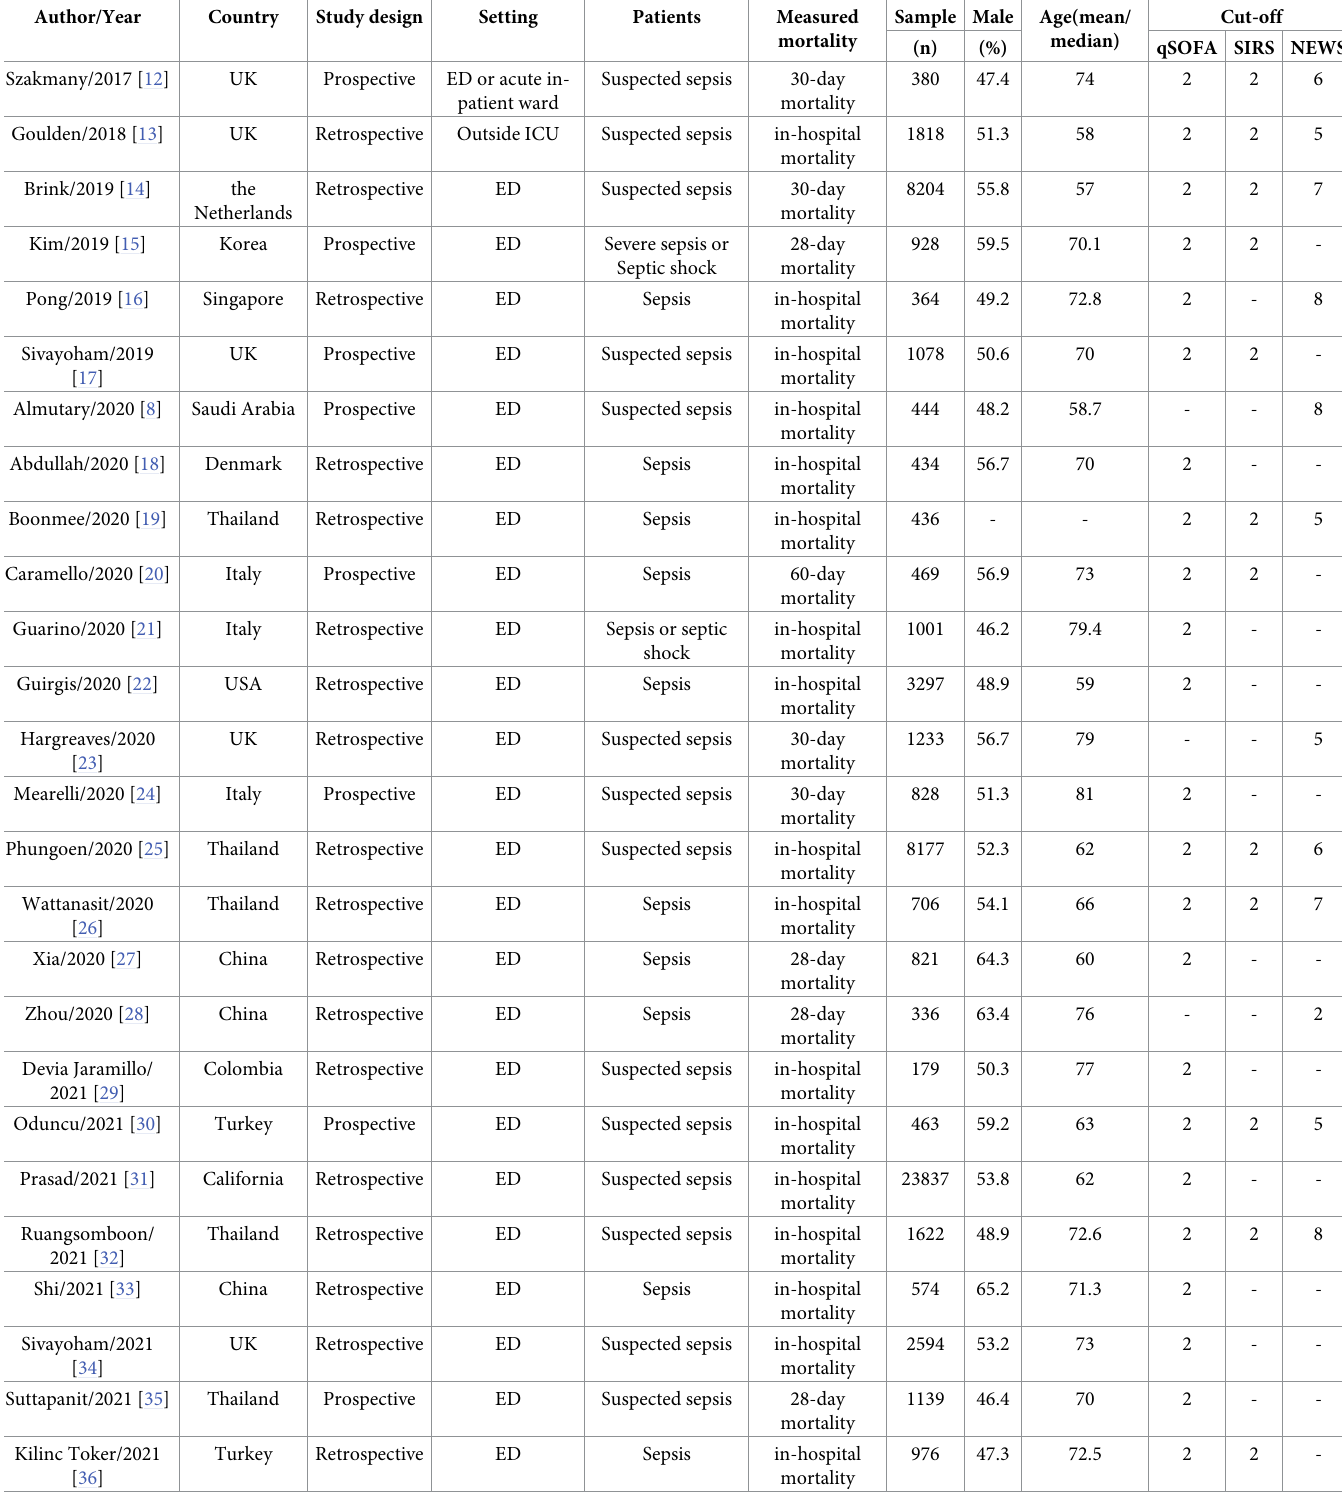
Table 1. Characteristics of included